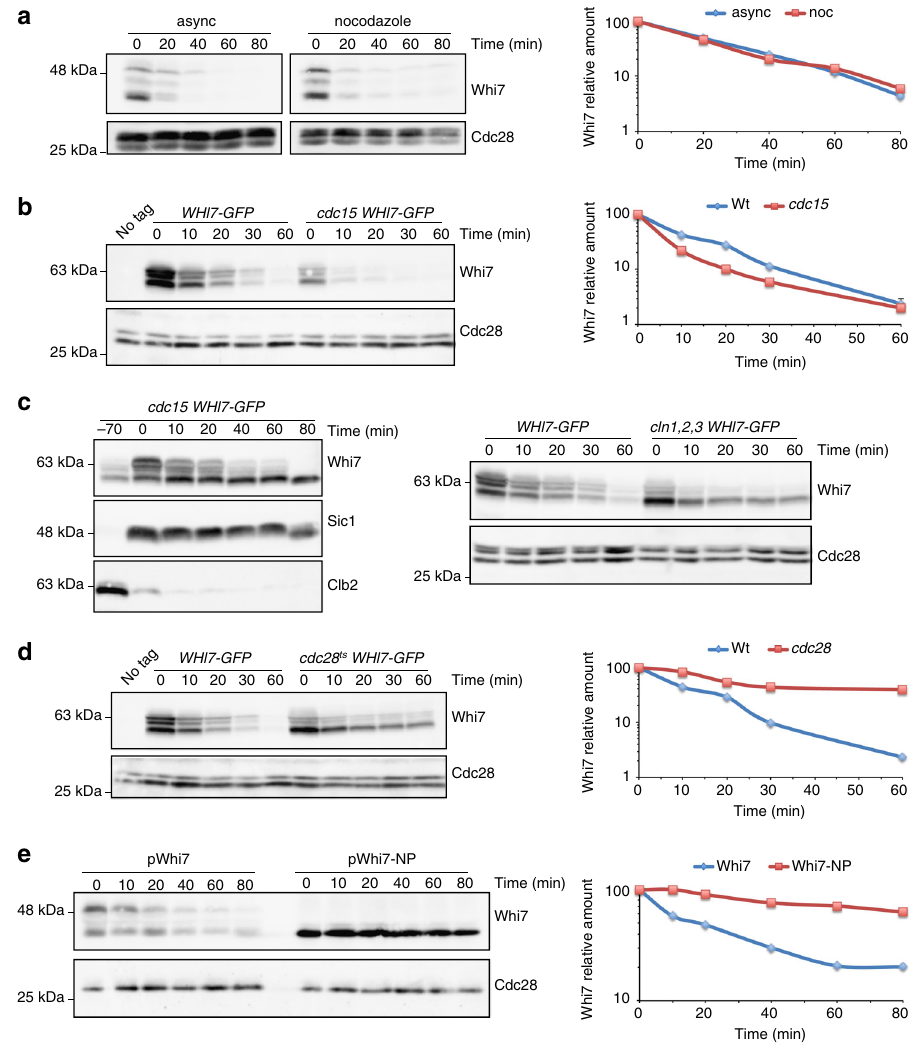
Fig. 3 Cell cycle regulation of Whi7 protein stability by Cdc28 phosphorylation. a Cells of the WHI7-HA (JCY1728) strain were incubated for 2 h in the presence of 15 μ g mL − 1 nocodazole ( > 90% of cells arrested at G2/M phase). Whi7 protein stability was analyzed as described in Fig. 2. b Wild-type (JCY1746) and cdc15 mutant (JCY1802) cells expressing GFP-tagged Whi7 were incubated at 37 °C for 3 h ( > 95% of cdc15 mutant cells arrested at telophase), and then Whi7 protein stability was analyzed. c left panel: cdc15 cells expressing GFP-tagged Whi7 (JCY1802) were arrested in telophase by incubation at 37 °C. After 3 h, cells were released from the arrest and after 50 min, 100 μ g mL − 1 cycloheximide was added. Whi7, as well as Clb2 and Sic1 as controls of cell cycle progression, were analyzed. No budding occurred during the experiment con fi rming that cells remain in G1 phase. right panel : wild type (JCY1746) and GAL1:CLN3 cln1 cln2 (JCY2008) cells expressing GFP-tagged Whi7 were grown on galactose, transferred to YPD medium and after 3 h (100% of cell in G1 in the mutant strain) Whi7 protein stability was analyzed. d Wild type (JCY1746) and cdc28 mutant (JCY1789) cells expressing GFP- tagged Whi7 were incubated at 37 °C for 3 h and then Whi7 protein stability was analyzed. e Whi7 protein stability in whi7 mutant cells (JCY1819) transformed with a centromeric plasmid that expresses the HA-tagged wild type (pWHI7) or a mutated protein in all consensus CDK phosphorylation sites